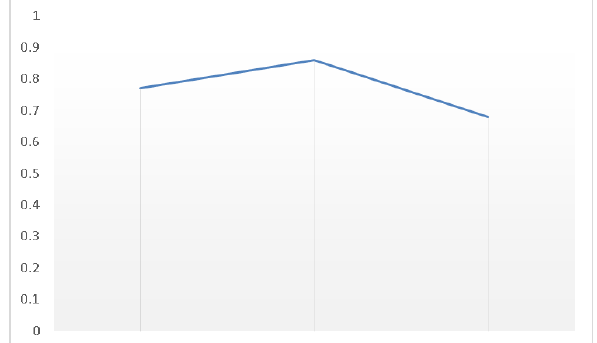
Fig. 3 Image changes after